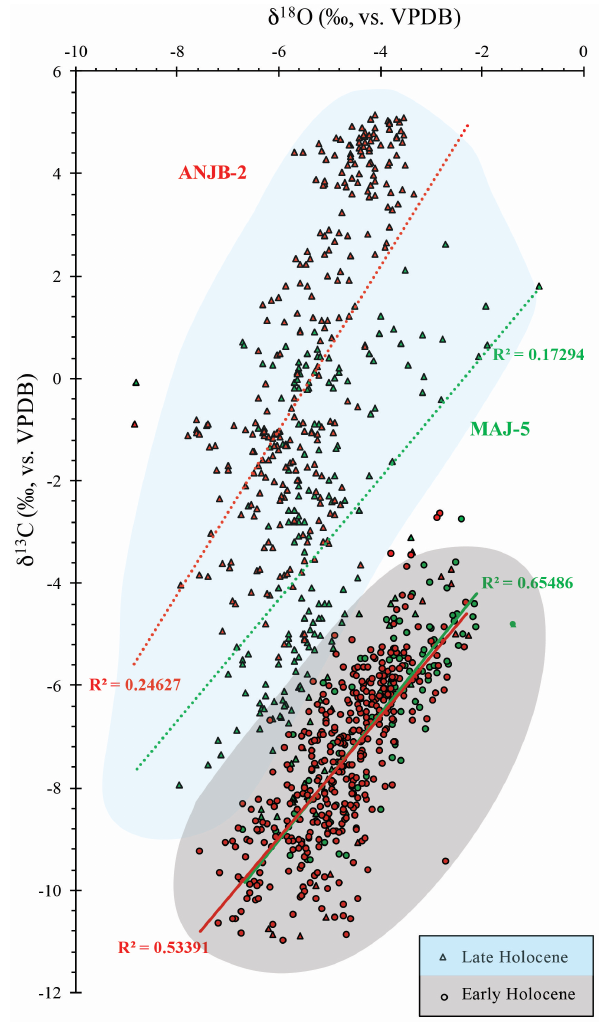
Figure 4. Stable isotope data. Scatter plots of δ 13 C and δ 18 O for Stalagmites MAJ-5 (green) and ANJB-2 (red) during the Malagasy early Holocene interval (circle) and the Malagasy late Holocene in- terval (triangle). The plot shows distinctive early and late Holocene conditions (roughly highlighted in gray and light blue,